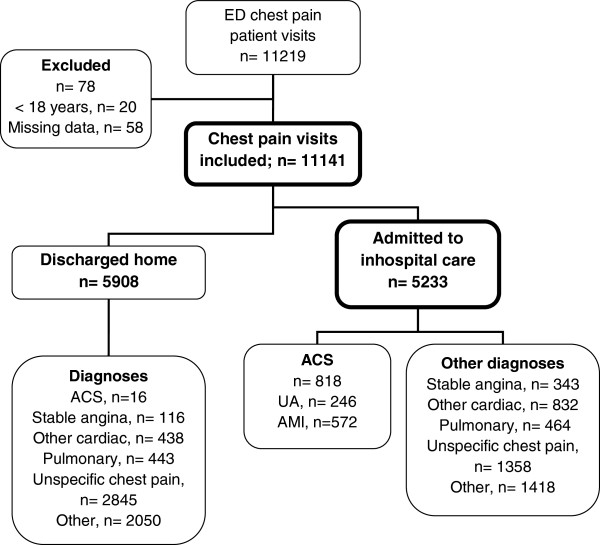
Patient flow chart.